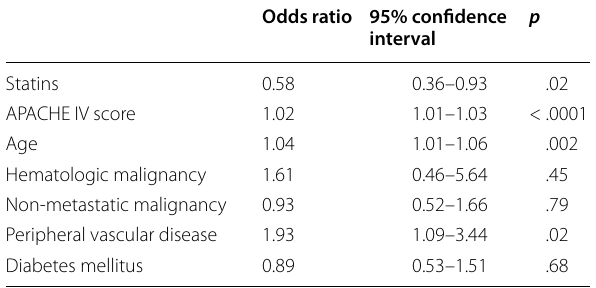
Table 3 Association of statin use with 30-day mortality using logistic regression in propensity-matched